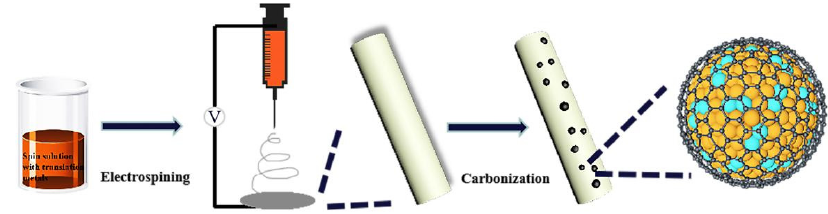
Figure 1. Schematic illustration of the synthesis process of the Ni x Fe y @C-CNFs. The controllable synthesis and compositions are confirmed by XRD measurements as Figure 2. Compared with the diffraction peaks of Ni and Fe, the diffraction peaks of NiFe alloy shift to some extent, which proves the formation of the alloy structure. The Ni 3 Fe 7 @C-CNFs samples showed characteristic peaks at 43.7°, 51.0°, and 74.8°, corre- sponding to the (111), (200) and (220) faces of the NiFe alloy, respectively. Except for the characteristic diffraction peaks corresponding to face centered cubic phase alloy, there are no other diffraction peaks, which proves that there are only single-phase alloys. The mag- nified portion of XRD pattern in the 2 θ range of 42–48° is provided on the right. The strongest diffraction peak shifts slightly at a small angle in a regular trend with the change of alloy composition, which proves that the lattice constant changes due to the formation of ideal alloy structure. All the composites show a major peak at 2 θ = 26°, corresponding to the typical (002) plane of graphitic carbon. Figure 2. XRD patterns of Ni x Fe y @C-CNFs and magnified portion in the 2 θ range of 42°–48°. After mixing the nitrate solution and the PVP uniformly, the precursor of NixFey@C- CNFs can be formed after electrospinning for 12 h. As shown in Figure 3a, the SEM mor- phology of the prepared precursor was characterized, from which the produced nano- fibers have a diameter of about 100 nm. The surface of carbon nanofibers is smooth and its morphology is uniform. Figure 3b shows that the precursor remains fibrous after high temperature carbonization, at which point the fiber becomes a highly conductive carbon material. Carbon nanofibers have the advantages of small size, large specific surface area and large aspect ratio. Therefore, electrons and protons can transfer in a controlled direc-